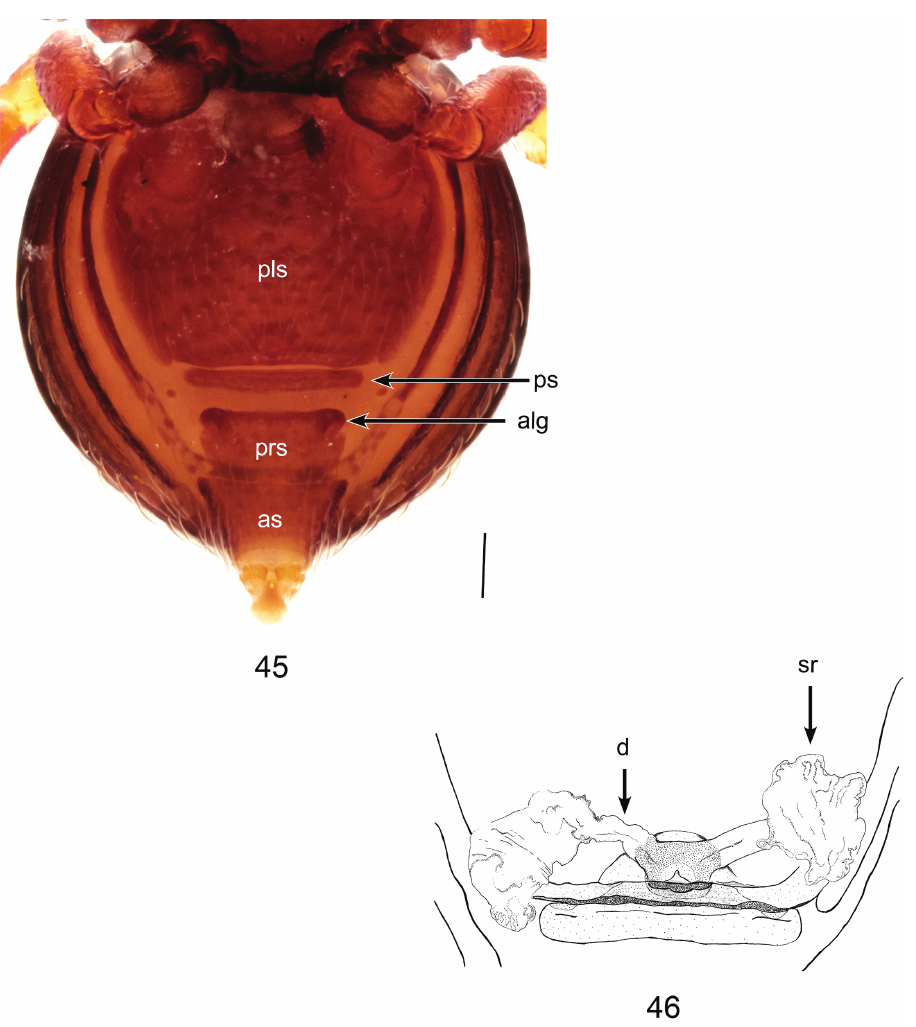
Figures 45, 46. Brignoliella patmae sp. n., female. 45 Abdomen, ventral view. 46 Schematic illustration of genitalia, dorsal view. Scale bar: 0.1